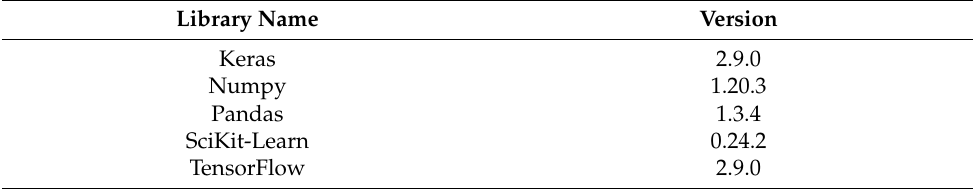
Table 8. The software libraries used from